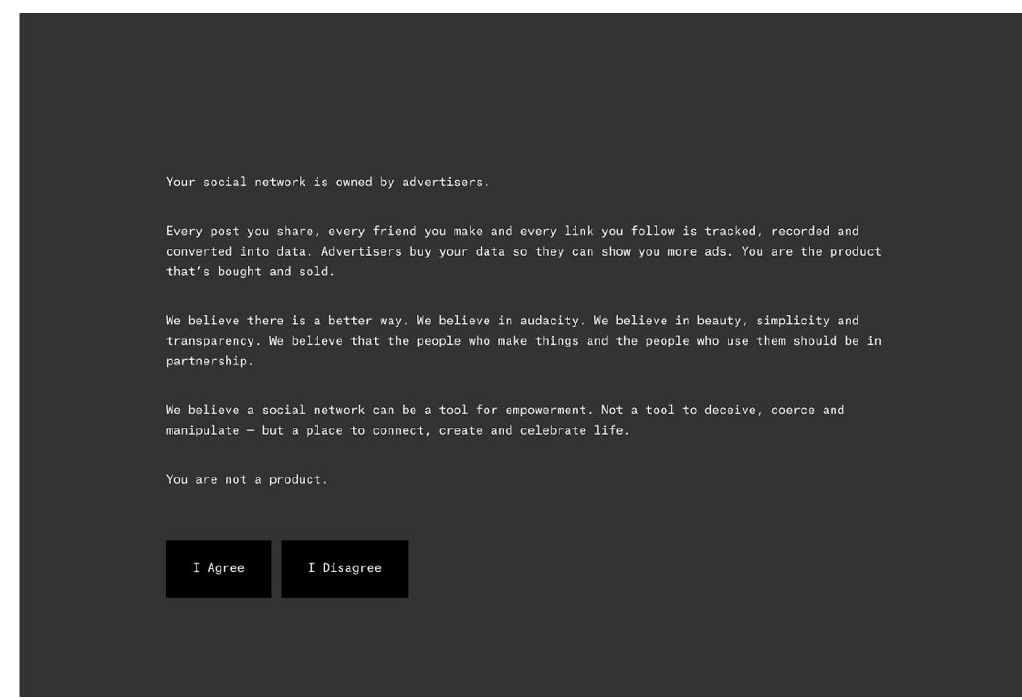
Figure 5. A screenshot from the Ello homepage, 25 June 2015 [97].